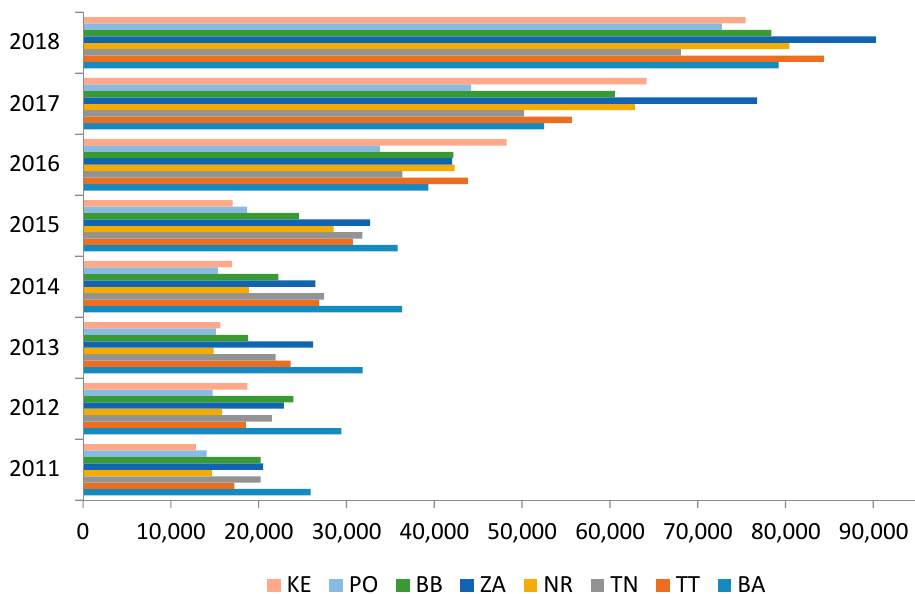
Figure 4. Development of the amount of separated municipal waste in the regions of Slovakia. Source: Based on data collected by the Statistical Office of Slovak Republic [29].